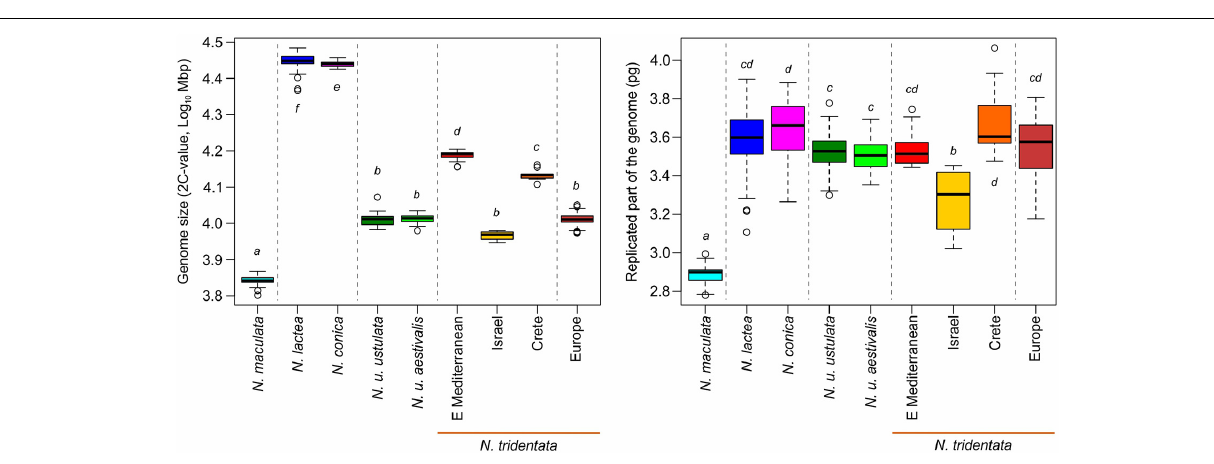
FIGURE 5 | Variation in genome size (Left) and in the size of the replicated part of the genome (Right) of diploid taxa/lineages. The arrangement of taxa and their coloration follows lineages differentiated in the RAxML tree ( Figure 6A ), and the main clades are separated by dotted lines. The letters next to each box indicate the groups detected in Tukey’s HSD test ( Table 1